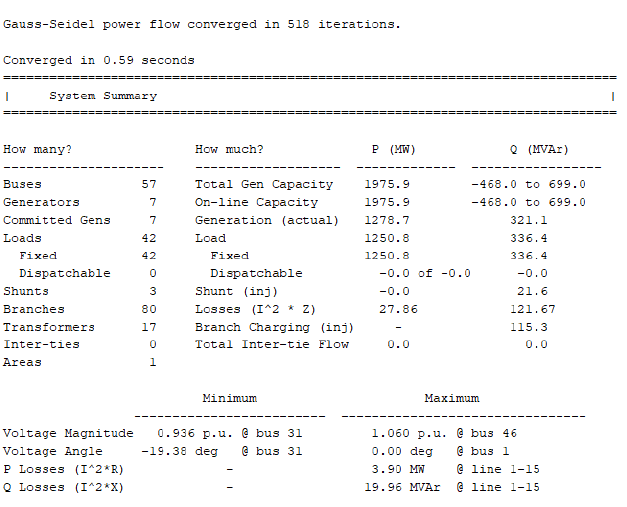
Figure 4. System summary and load flow analysis using Gauss – Seidel numerical method